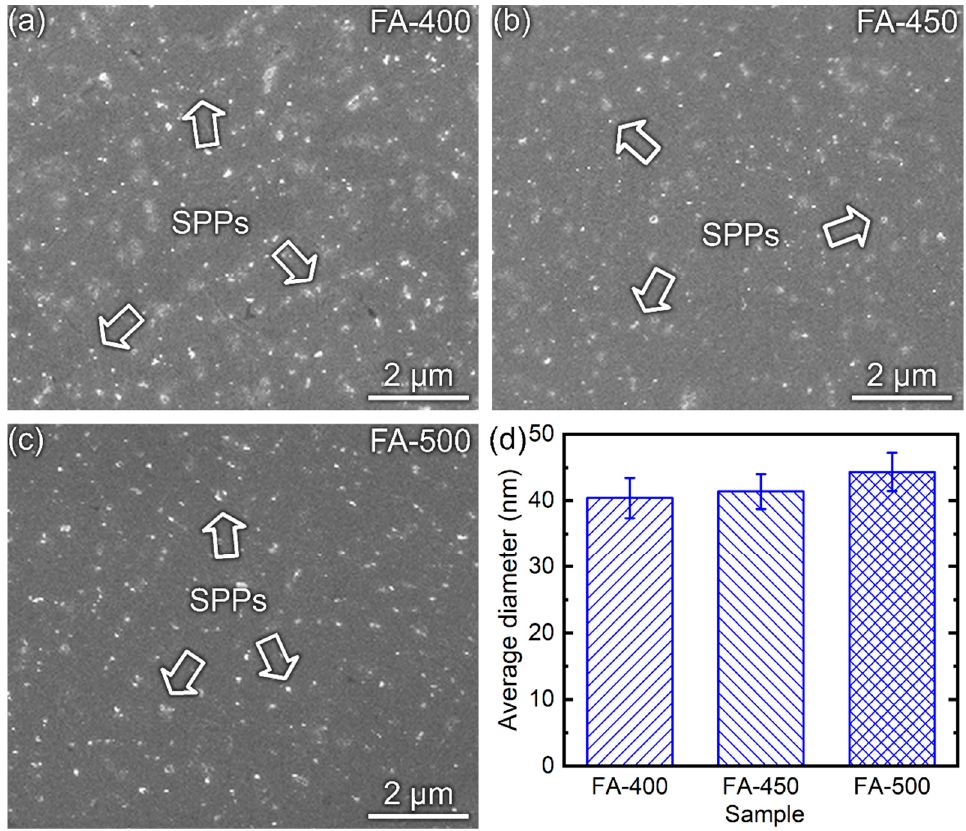
Figure 3. The SEM images for the microstructures of the alloy samples: ( a ) FA-400, ( b ) FA-450 and ( c ) FA-500, and ( d ) the corresponding statistical information of the second-phase particles (SPPs). Metals 2019 , 9 , x FOR PEER REVIEW 7 of 18